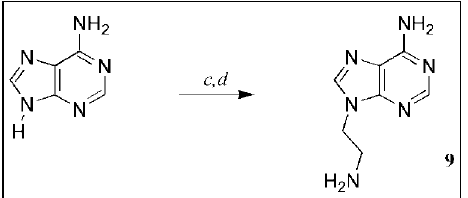
Figure 4 - Synthesis of com- pound 9. c , 2-Bromo-1-[(tert- butyloxycarbonyl)amino]ethane, K 2 CO 3 , Bu 4 N + I - ; DMF (RT, room temperature for 16 h). d , Trifluo- roacetic acid; CH 2 Cl 2 (RT for 4 h).